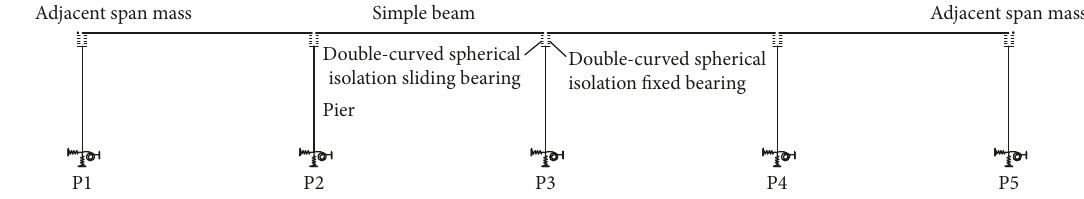
Figure 8: Stick model of the multi-span simply-supported beam.